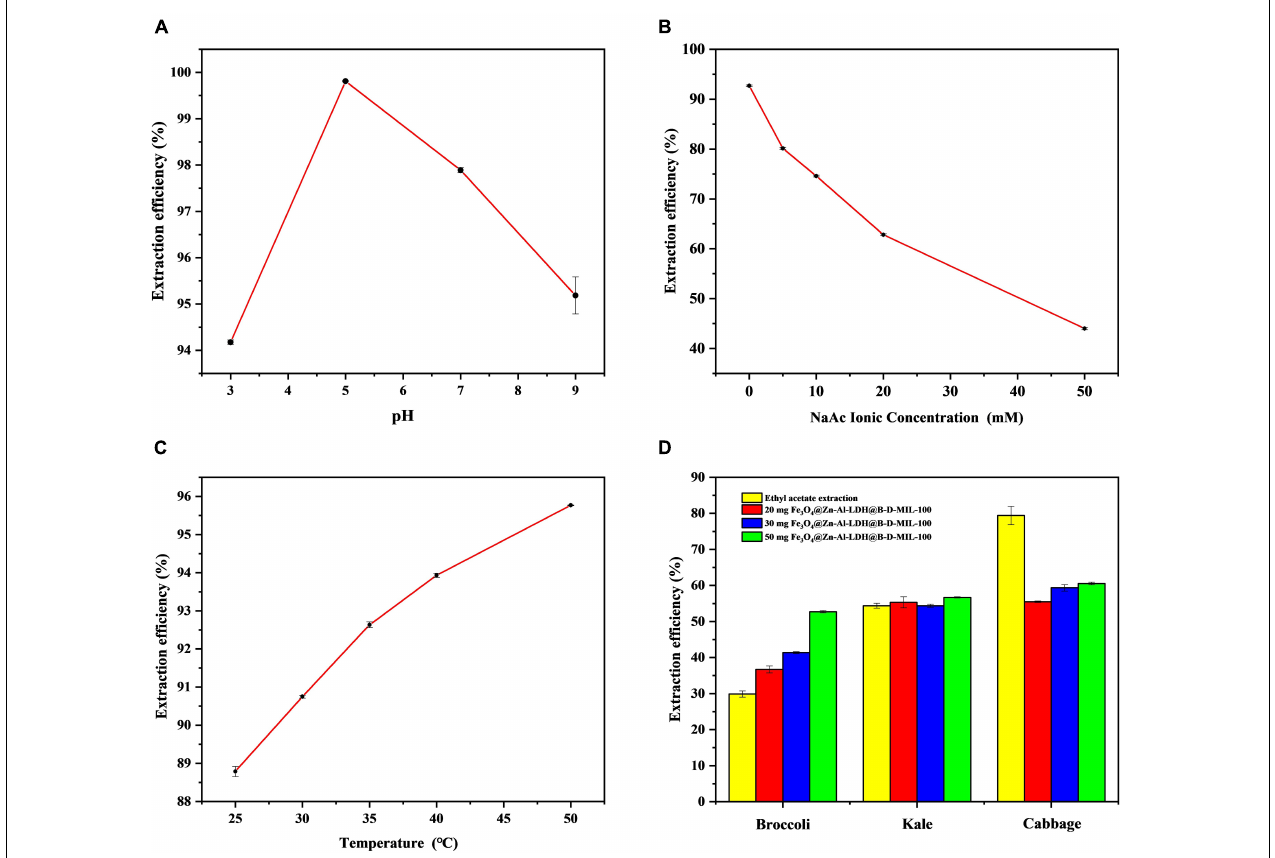
FIGURE 8 | Optimization of the (A) pH, (B) ionic strength, and (C) temperature, and (D) actual sample extraction